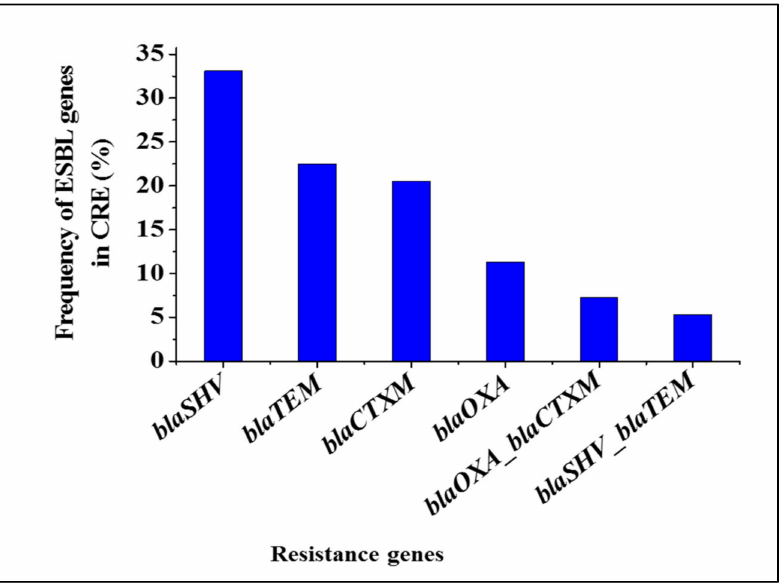
Figure 6. Frequency of ESBL-encoding genes detected in CRE isolated from cattle